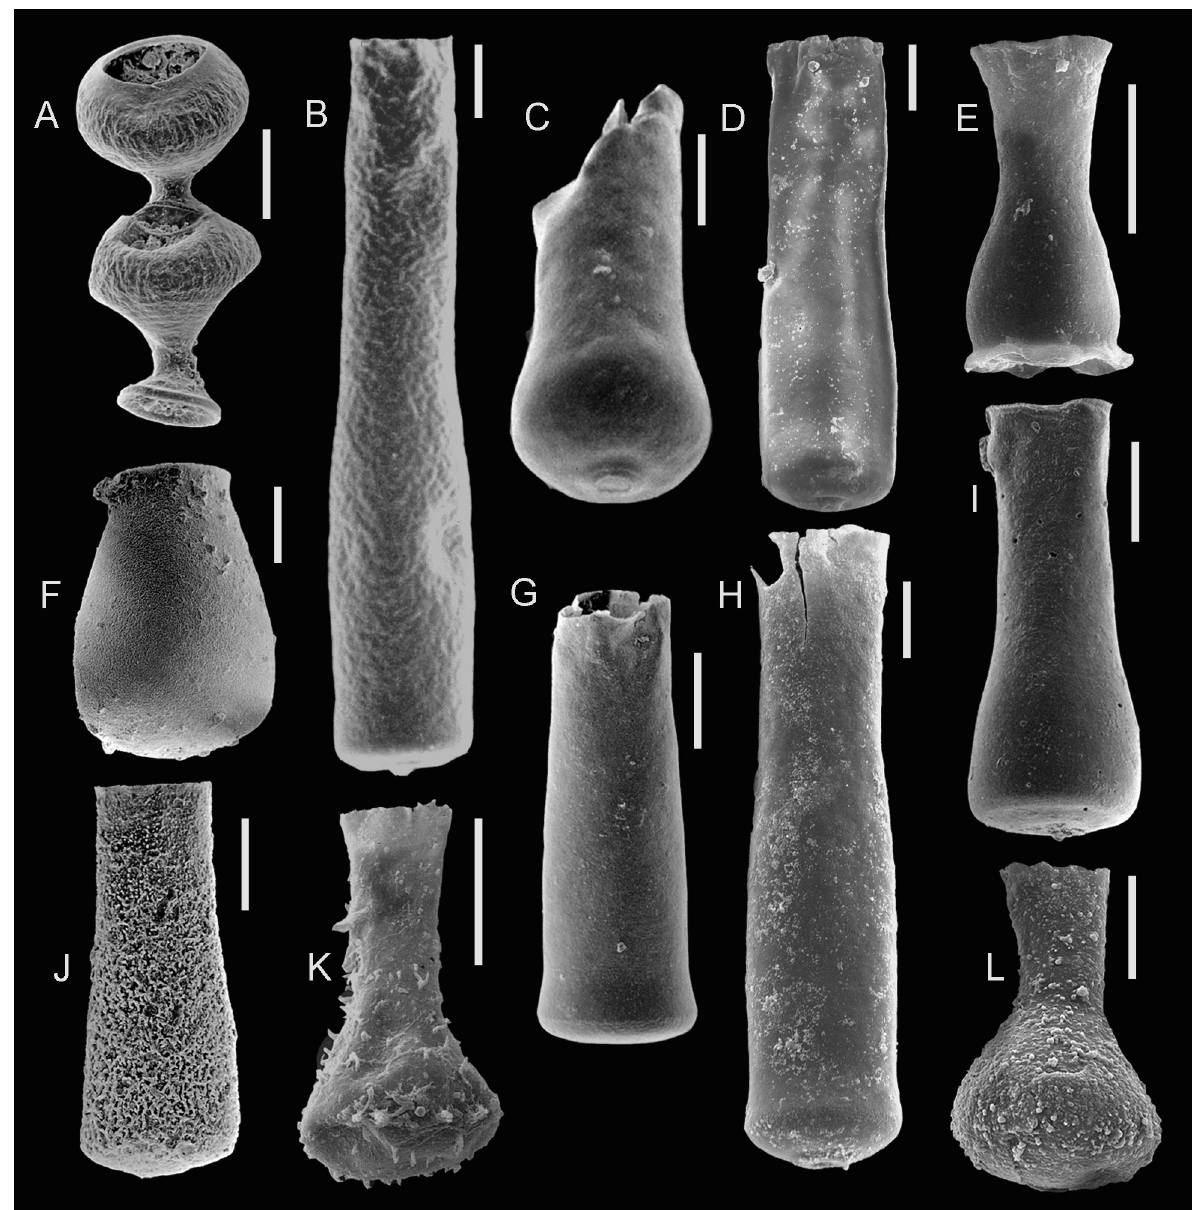
Fig. 5. Chitinozoan biozonal species in the Wenlock of the East Baltic drill cores. Scale 50 (cid:181)m. A , Margachitina margaritana (Eisenack), GIT 220-9, Ohesaare core, depth 300.70 m, Jaani Stage. B , Conochitina claviformis Eisenack, GIT 272-69,